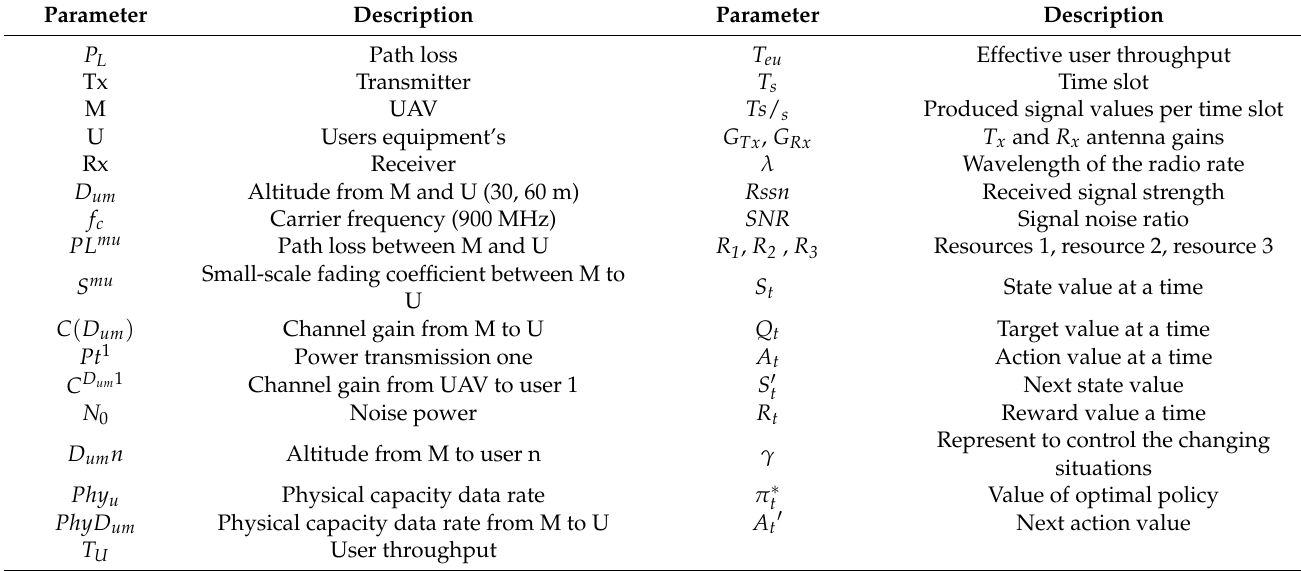
Table 2. List of